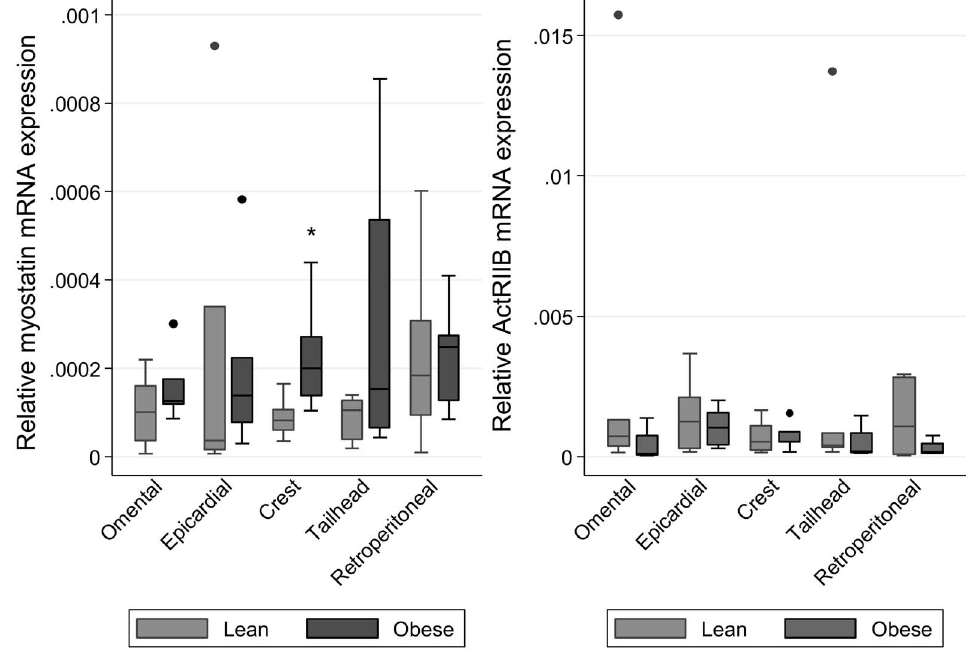
Figure 2. Gene expression of Myostatin and ActRIIB in adipose tissues of lean and obese horses and ponies. Gene expression was analysed by real-time PCR and the geometric mean of the two most stable housekeeping genes as determined by GeNorm (RPL32 and beta-actin) was used for normalisation. Relative transcript abundance is shown for Myostatin (A) and ActRIIB (B). *denotes where values differ significantly (p , 0.05) from lean group. n=6/group.